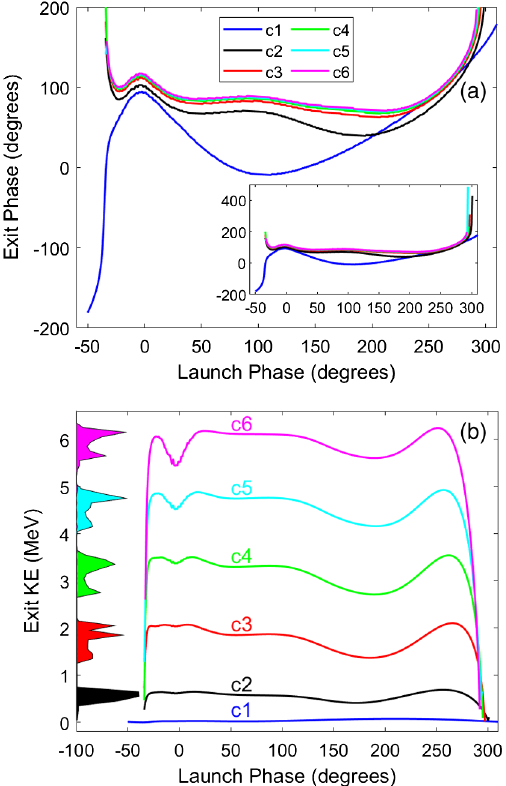
FIG. 10. 1D tracking results with optimized field profile: (a) exit phase vs launch phase and (b) exit KE vs launch phase. The inset of (a) is given to show a larger range of exit phases. The y projection of the curves shows the KE spectrum (in arbitrary units) at the corresponding cell exits.